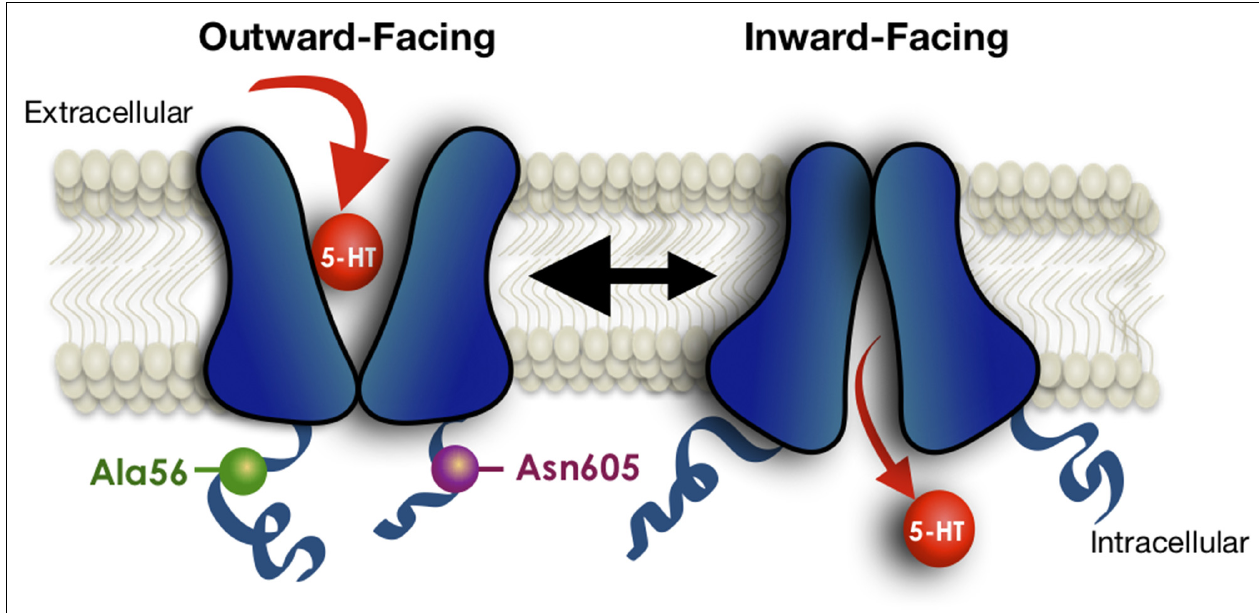
FIGURE 3 | Schematic indicating conformational bias of SERT Ala56 and Asn605 relative to WT SERT. Limited proteolysis, fluorescence resonance energy transfer (FRET), and cysteine-accessibility studies indicate that the Ala56 and Asn605 coding variants impose conformation that leading to a more outward-facing conformation of the transporter, facilitating access of 5-HT to the substrate-binding site under resting conditions. Modified from Quinlan et al.